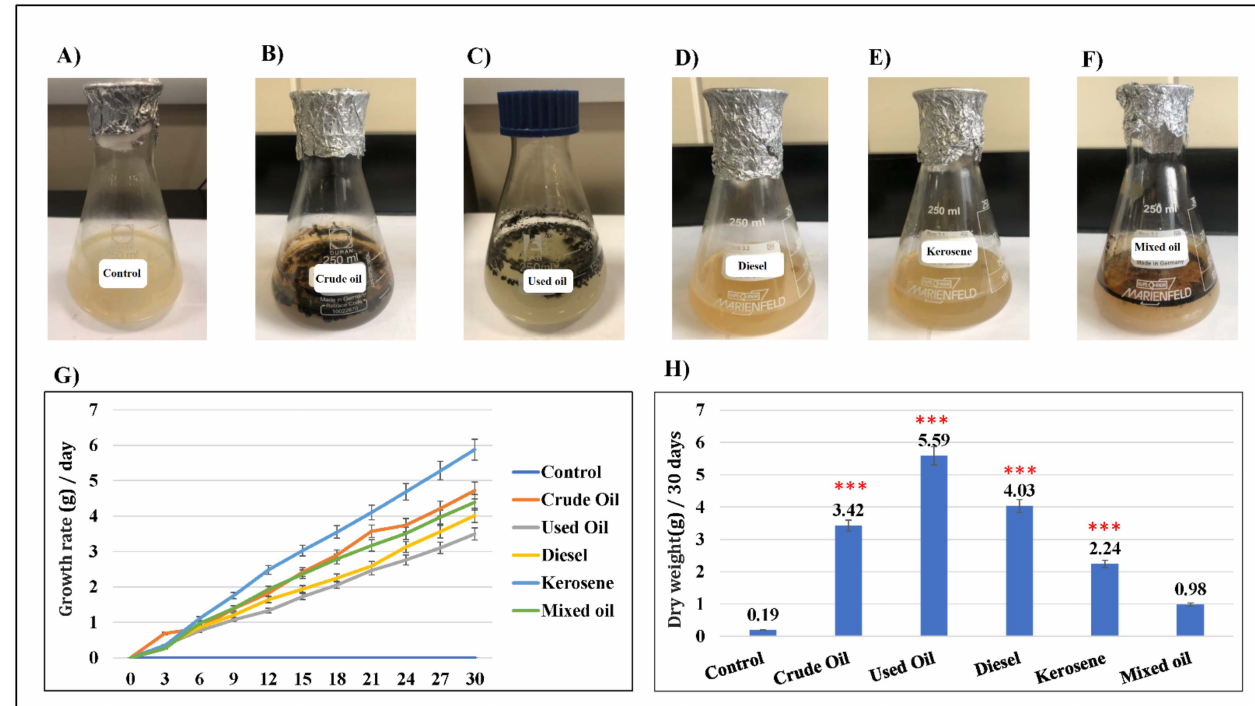
Figure 2. The ability of D. spicifera to tolerate effects of different hydrocarbons in liquid medium. The growth of D. spicifera was tested in liquid MSM media for 30 days in the presence of 1% of different hydrocarbons. ( A ) MSM media without any treatments (control), ( B ) crude oil, ( C ) used oil, ( D ) diesel, ( E ) kerosene, ( F ) mixed oil, ( G ) real-time measurement of the fungal growth in grams with different treatments, ( H ) comparison of the D. spicifera dry weight in grams after 30 days. *** indicates p < 0.001.